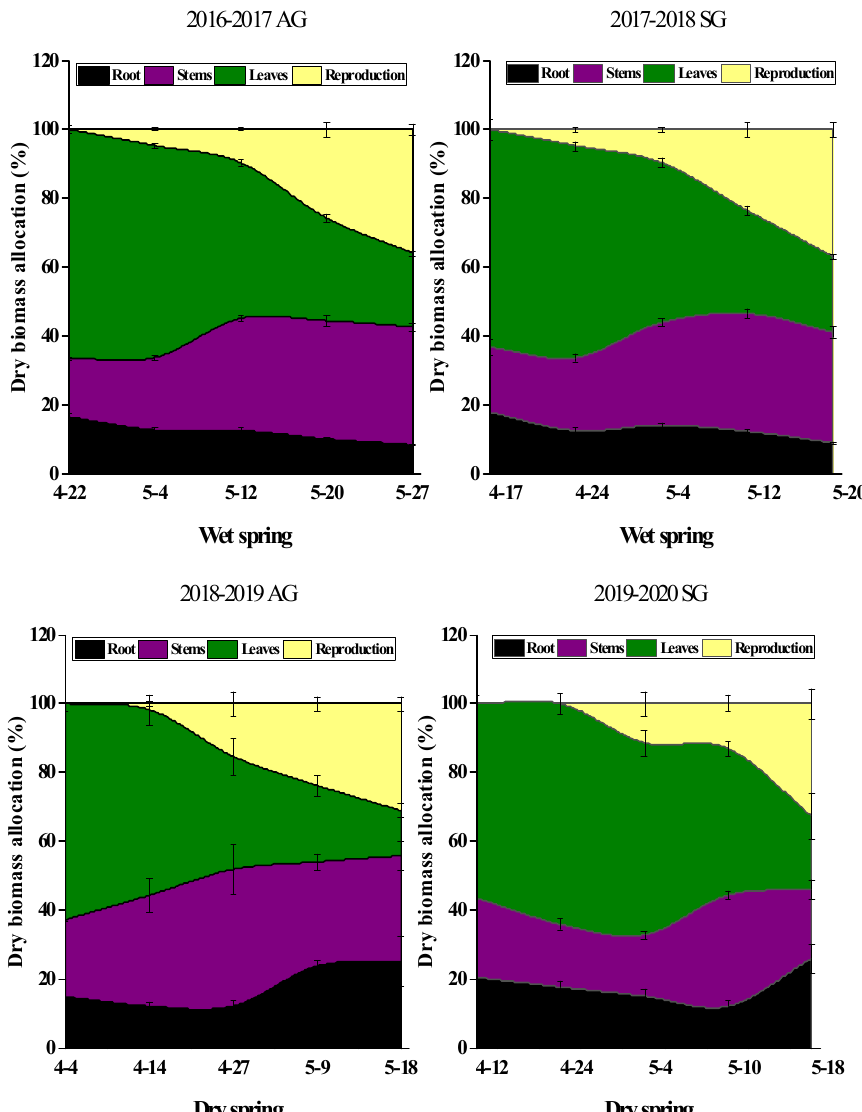
Figure 11. Changes in dry biomass allocation of spring (SG)- and autumn (AG)- germinating plants of Erodium oxyrhinchum in wet ( left ) and dry ( right ) springs. X axis represents different growth periods. The first three periods represent the vegetative stage, and the last two periods represent the reproductive stage. Vertical bars indicate standard errors of the means (n =